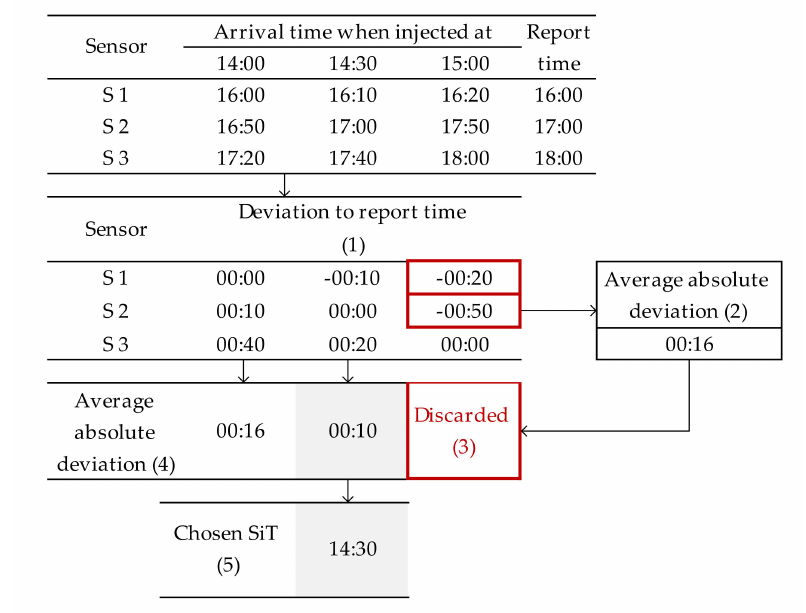
Figure 8. Suspect injection time (SiT) set cut process of the sample network (Node 5 as a SiL).